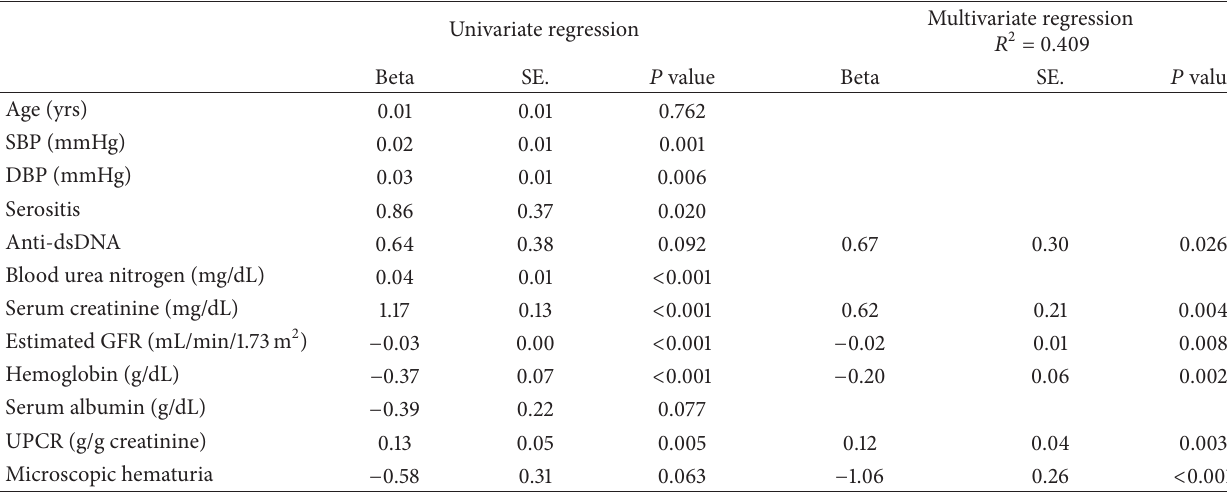
Table5:Univariateandmultivariateregressionanalysesdemonstratingclinicalfactorsshowingcorrelationwithrenalpathologicalchronicity index